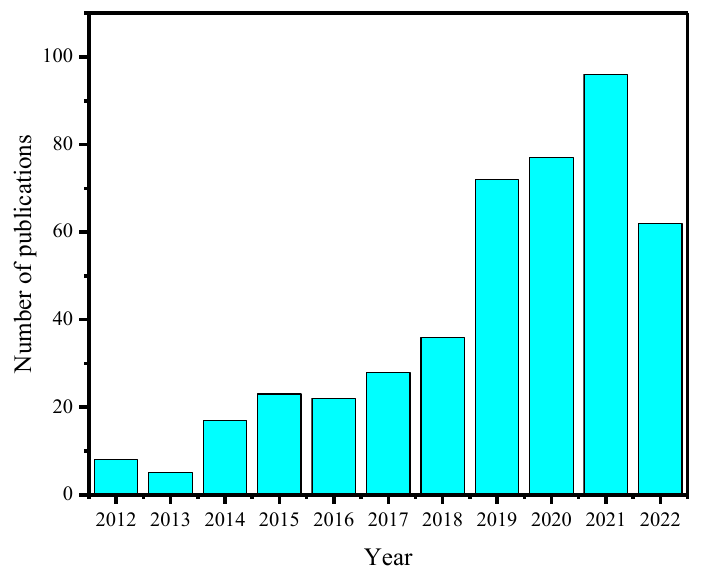
Figure 1. The increasing number of publications on AIE-type metal NCs over the years between 2012 and 2022 (data statistics from the Web of Science in January 2023, using keywords of AIE and metal nanoclusters).